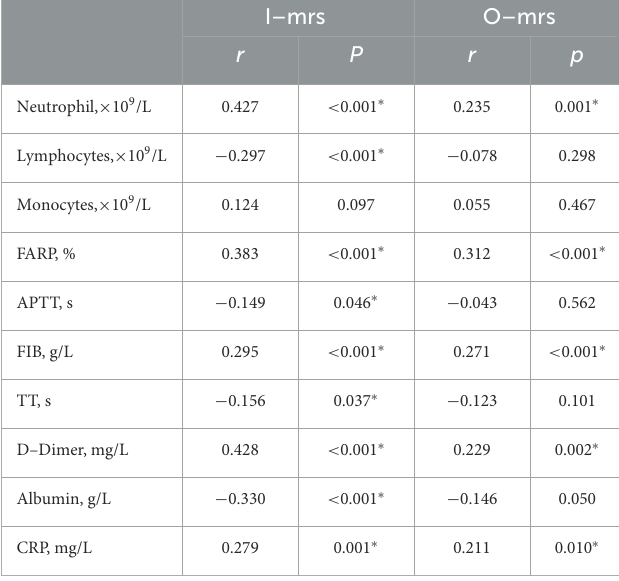
TABLE 5 Correlation analysis of clinical data and mRS scores.